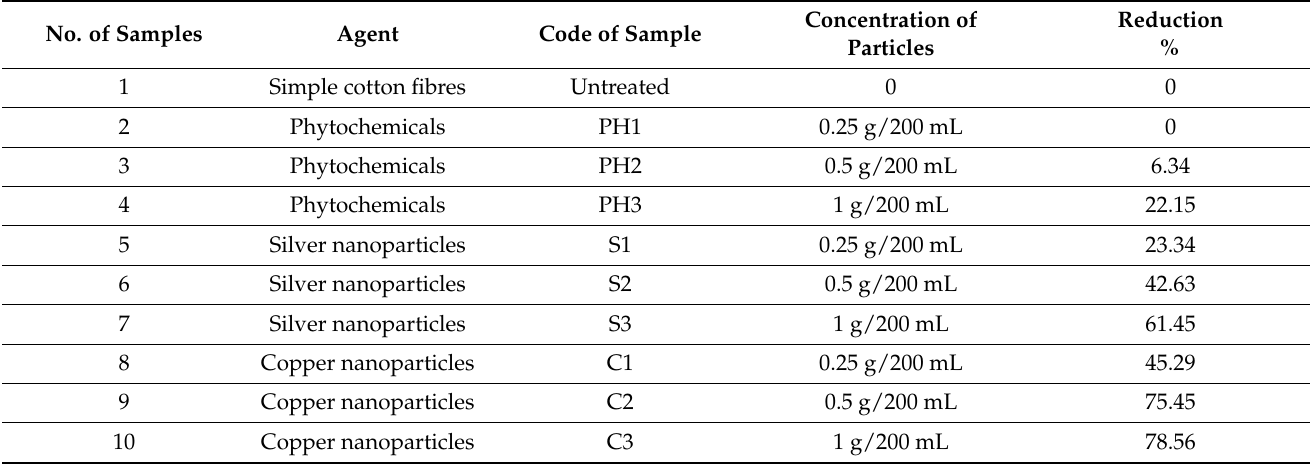
Table 6. Reduction percentage of antifungal activity.